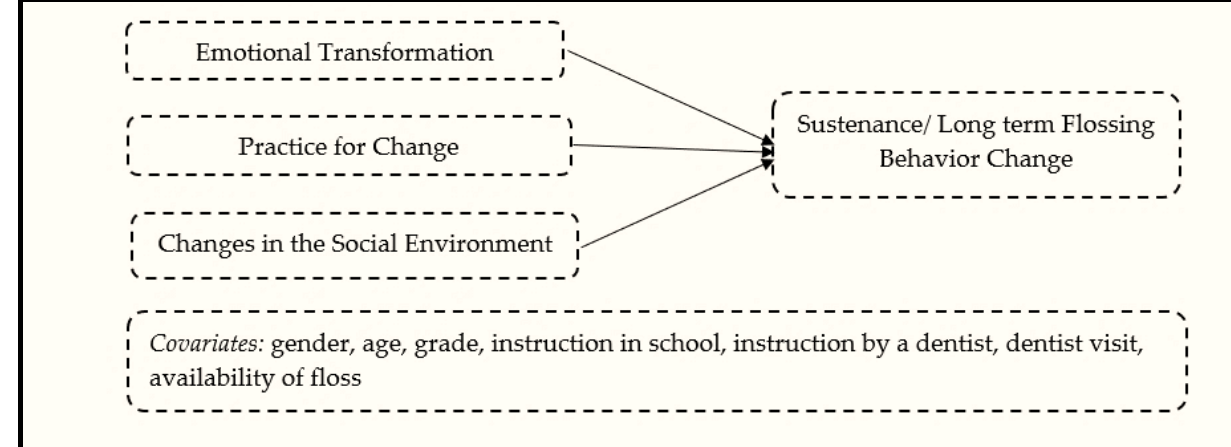
Figure 2. Diagrammatic depiction of the sustenance model of the MTM for promoting flossing among African American/Black and Latinx/Hispanic adolescents.